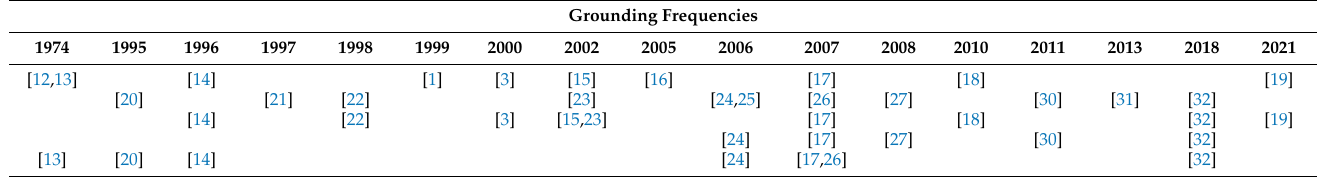
Table 1. Ship grounding frequency estimation models—classification framework. Grounding